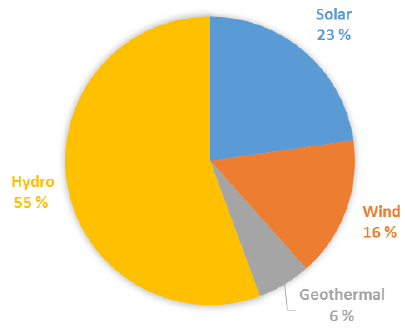
Figure 9. RES share in the electricity sector in Italy.